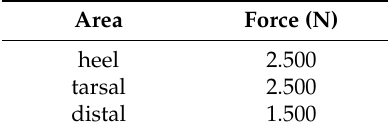
Table 3. Maximum force transmitted to the hinges of the prosthesis in a gait cycle.